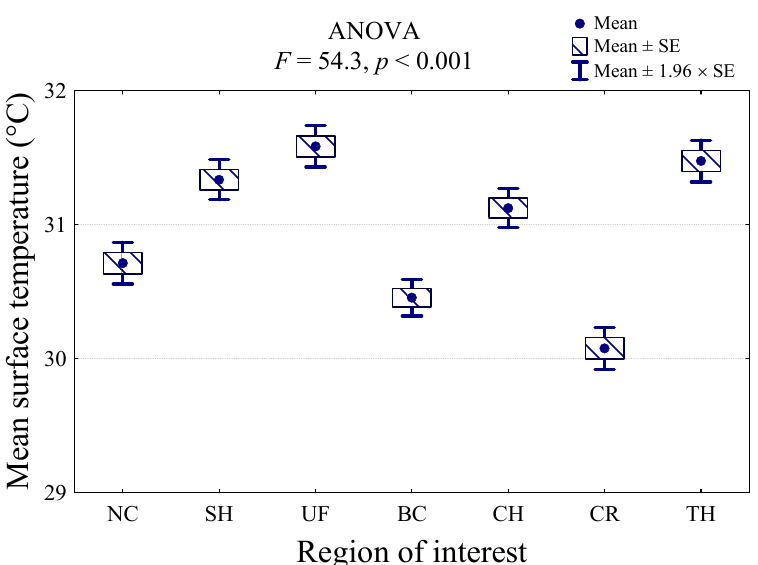
Figure 2. Comparison of average body surface temperature at seven regions of interest (ROIs): croup (CR), back (BC), neck (NC), chest (CH), shoulder (SH), thigh (TH), and upper forearm (UF) measured before treadmill exercise, immediately after each exercise, and during recovery time in nine dogs. Statistical analysis showed higher values of body surface temperature of all ROIs at AC and JAE, and the lowest temperatures at 120 AE ( p < 0.001; F = 31.3) (Figure